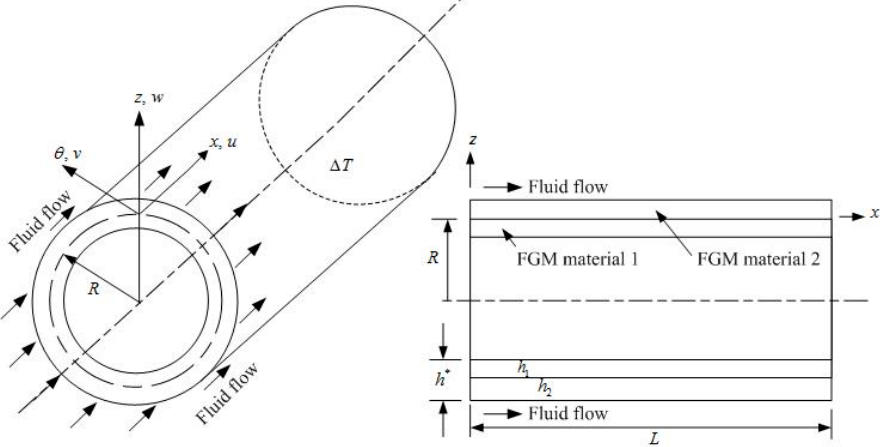
Figure 1. Fluid flow over the outer surface of two-material FGM circular cylindrical shells.